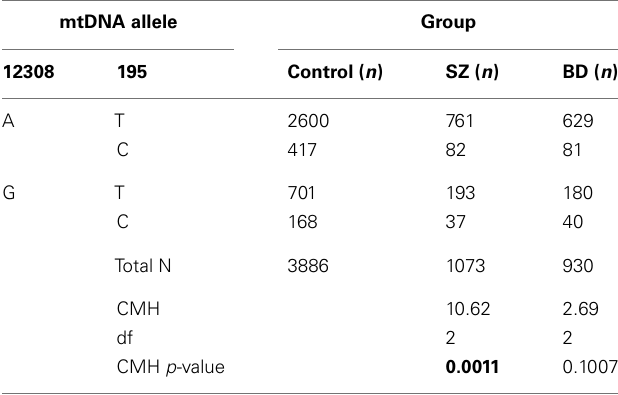
Table 5 |The haplogroup defining SNP (A12308G) and theT195C allele in D-Loop region were tested in a post hoc analysis using a Cochran–Mantel–Haenszel (CMH) test for repeated 2 × 2 tests of